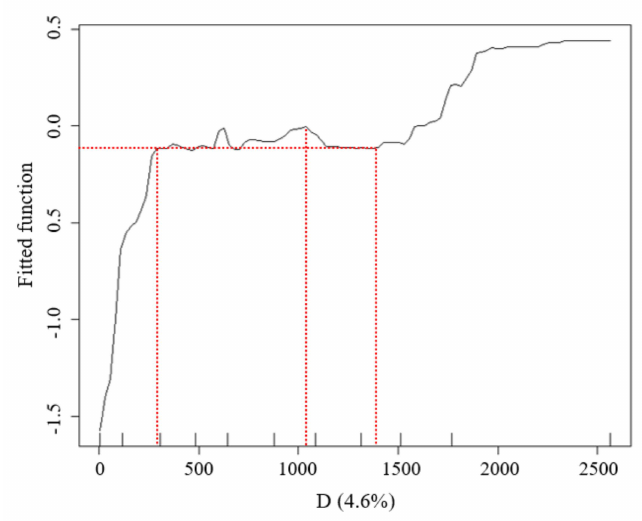
Figure 19. Relationship between the D factors and LST of the waterfront green space in the buffer zone of Width-IV river corridors.